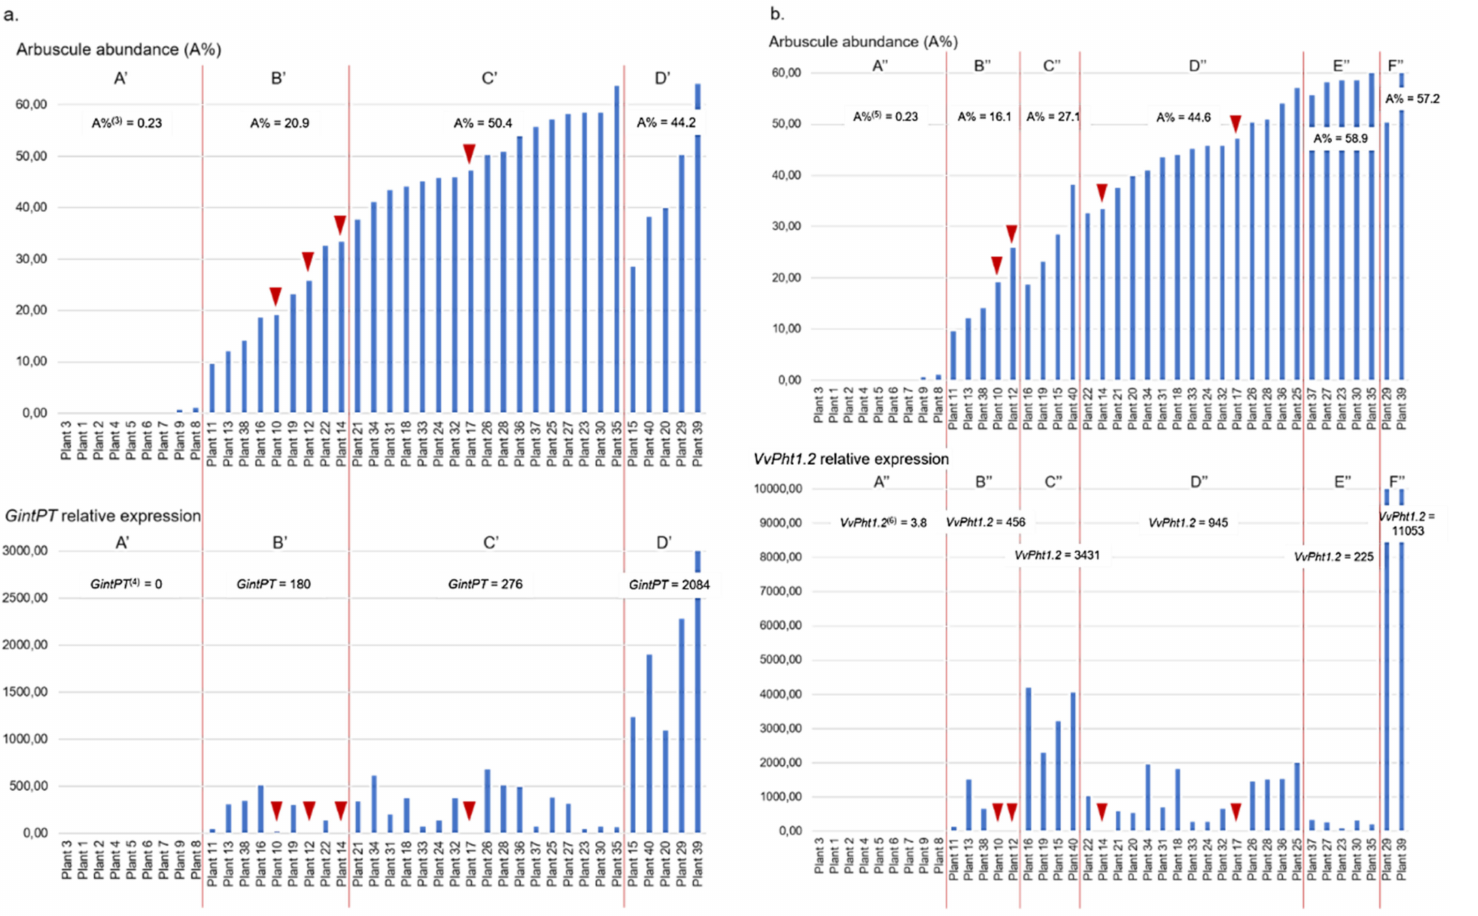
Figure 2. ( a ) Arbuscule abundance and relative expression of GintPT gene in 40 grapevine plants. A’, B’, C’, D’: clusters obtained by AHC on AMF-inoculated plants according to their arbuscule abundance and GintPT expression (3) : mean of arbuscule abundance of the cluster. (4) : mean of GintPT gene relative expression of the cluster. ( b ) Arbuscule abundance and relative expression of VvPht1.2 gene in 40 grapevine plants. A”, B”, C”, D”, E”, F”: clusters obtained by AHC on AMF-inoculated plants according to their arbuscule abundance and VvPht1.2 expression. (5) : mean of arbuscule abundance of the cluster. (6) : mean of VvPht1.2 gene relative expression of the cluster. Red triangles point to outstanding